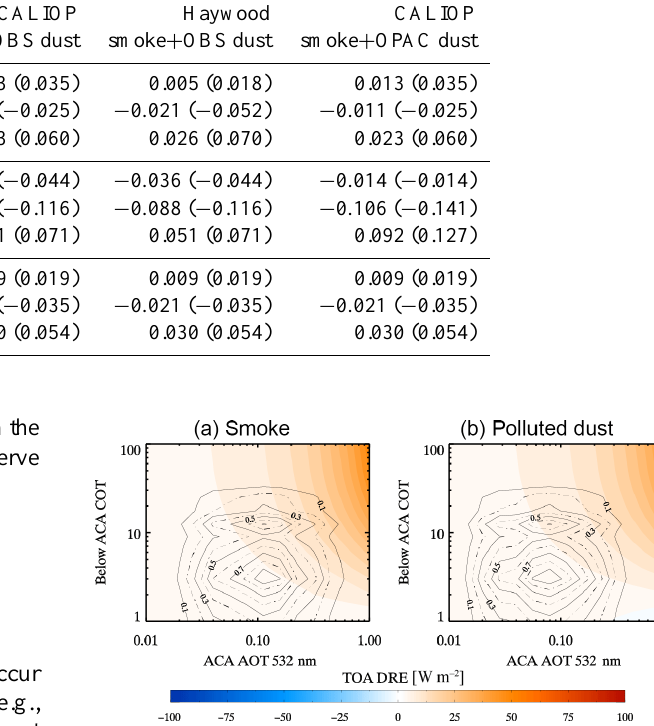
Figure 9. Diurnally averaged TOA above-cloud aerosol DRE as a function of COT and above-cloud AOT for the CALIOP smoke (a) and polluted dust (b) models. Also plotted for each aerosol model are the joint PDFs of above-cloud AOT and underlying COT (line contours); PDFs are obtained from the entire 8-year JJA record for the SE Atlantic region. Here, the solar zenith angle is assumed to be 24 ◦ and CER is assumed to be